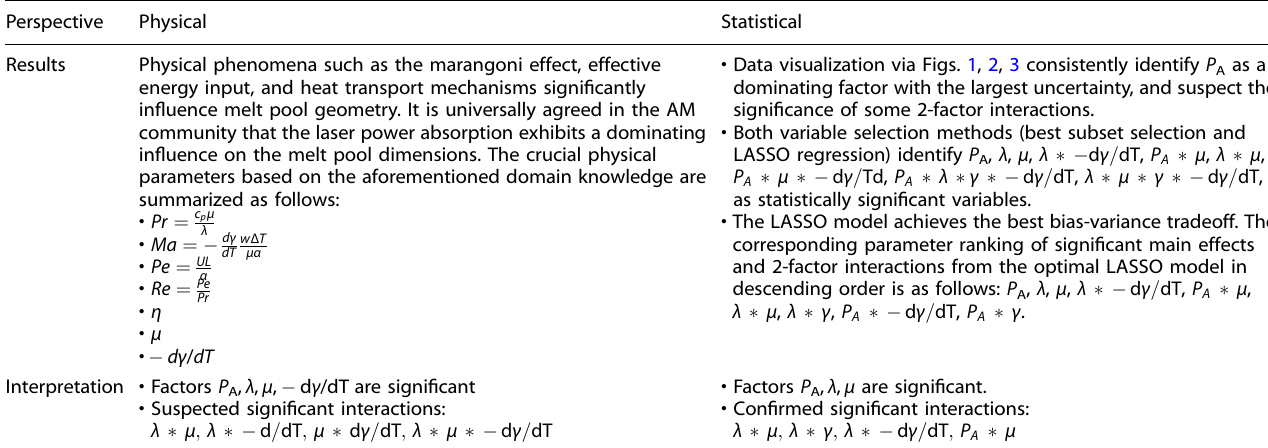
Table 7. Signi fi cant factors identi fi ed from the physical and statistical perspectives. Perspective Physical Statistical